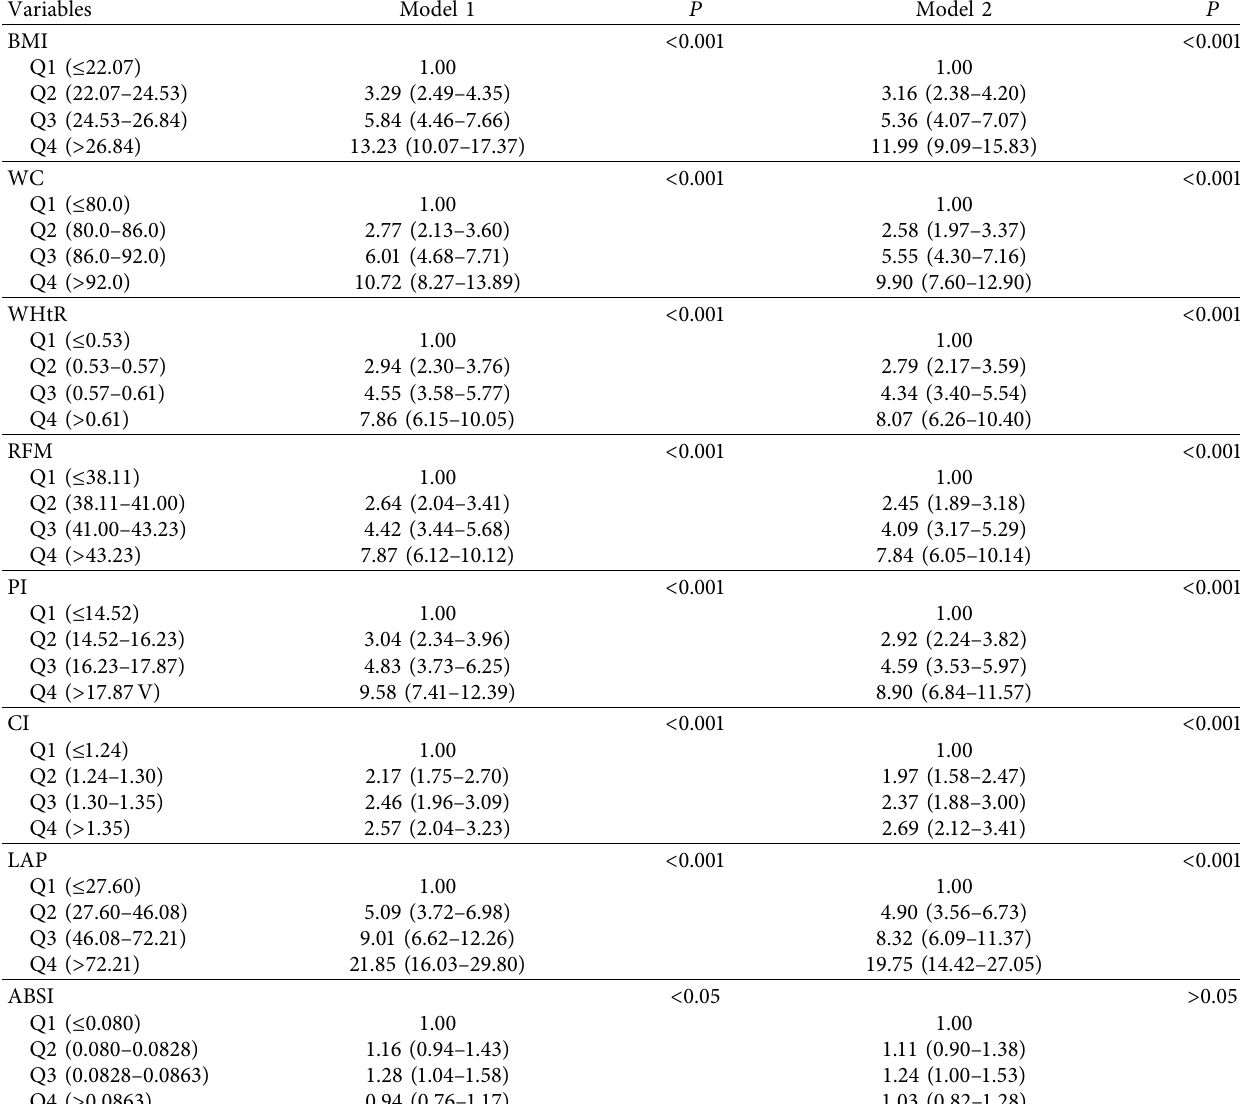
Table 4: Multivariate logistic of anthropology indexes for NAFLD in